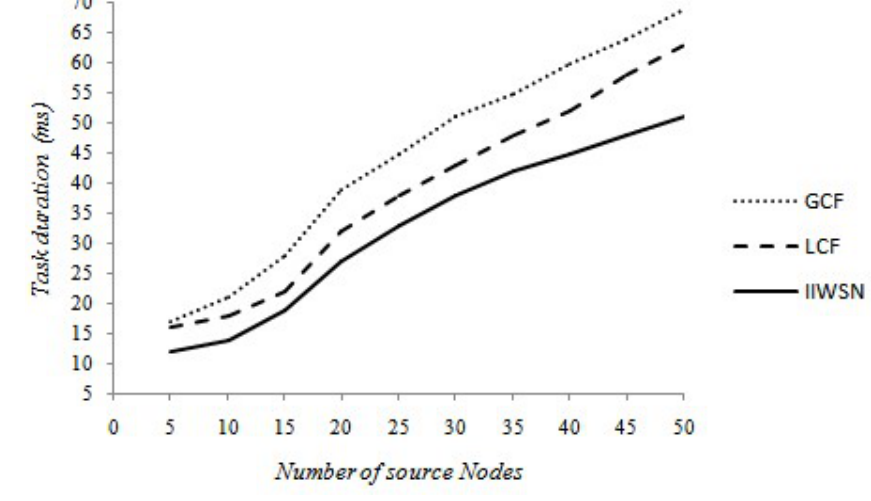
Figure 8. Comparison of task duration.